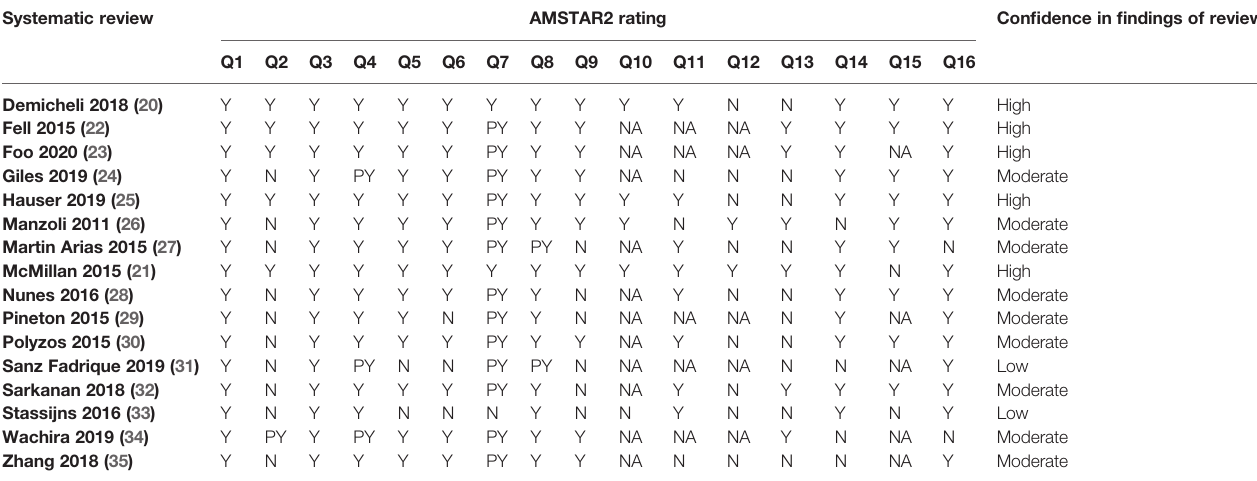
TABLE 2 | AMSTAR2 rating of 16 included systematic reviews. Systematic review AMSTAR2 rating Con fi dence in fi ndings of